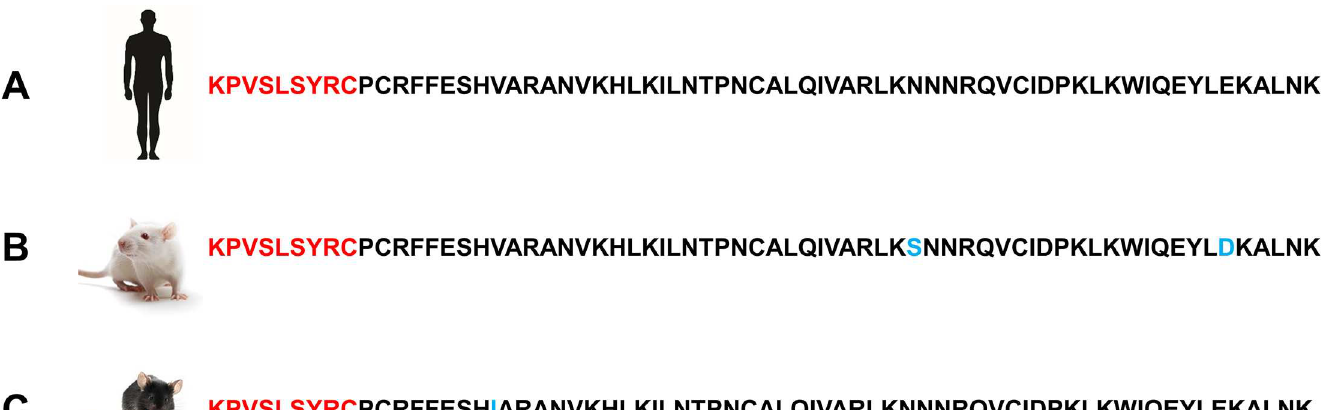
Fig 2. SDF-1 α sequence according to species. Alignmentof SDF-1 α from humans,rats and mice demonstrates the N-terminal sequenceis highly conservedbetweenspecies. Accession numbers NP_001171605.1, NP_001029055.1and NP_001012495.1were used, respectively.Sequences in red represent the sequenceof interest used to generateHCI.SDF1. Blue residues representdifferencesin the primary sequencebetweenspecies; note that none of these are at the N-terminal end.